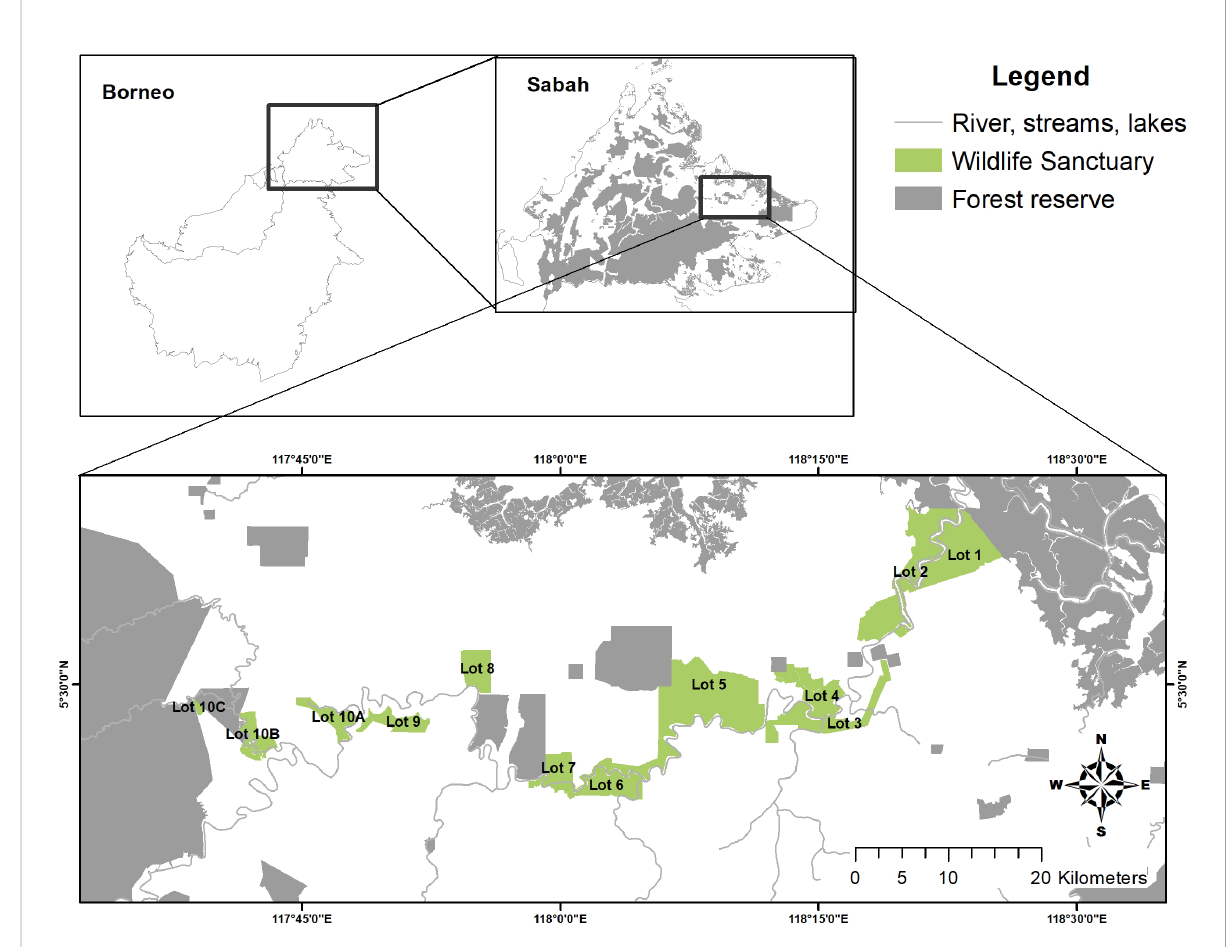
FIGURE 1 Map of the study region, the Lower Kinabatangan Wildlife Sanctuary.